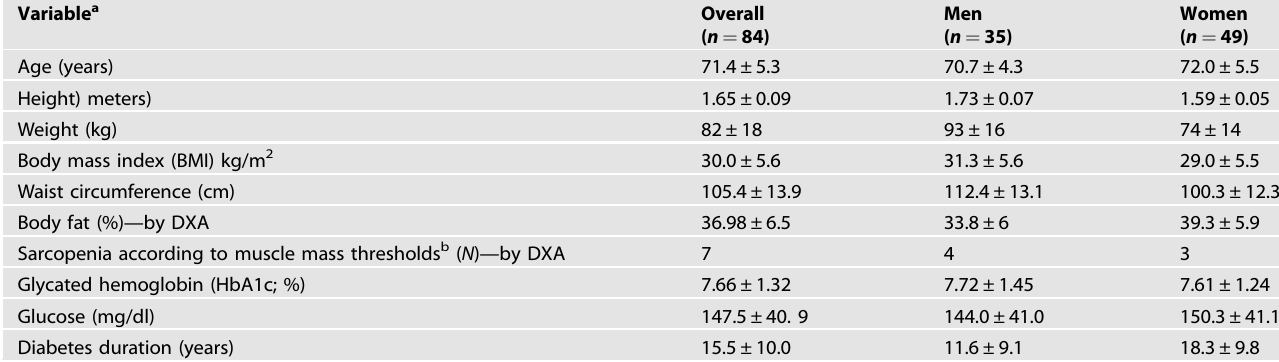
Table 1. Data of the study participants for whom baseline measurements were performed on both DSMF-BIA and DXA.